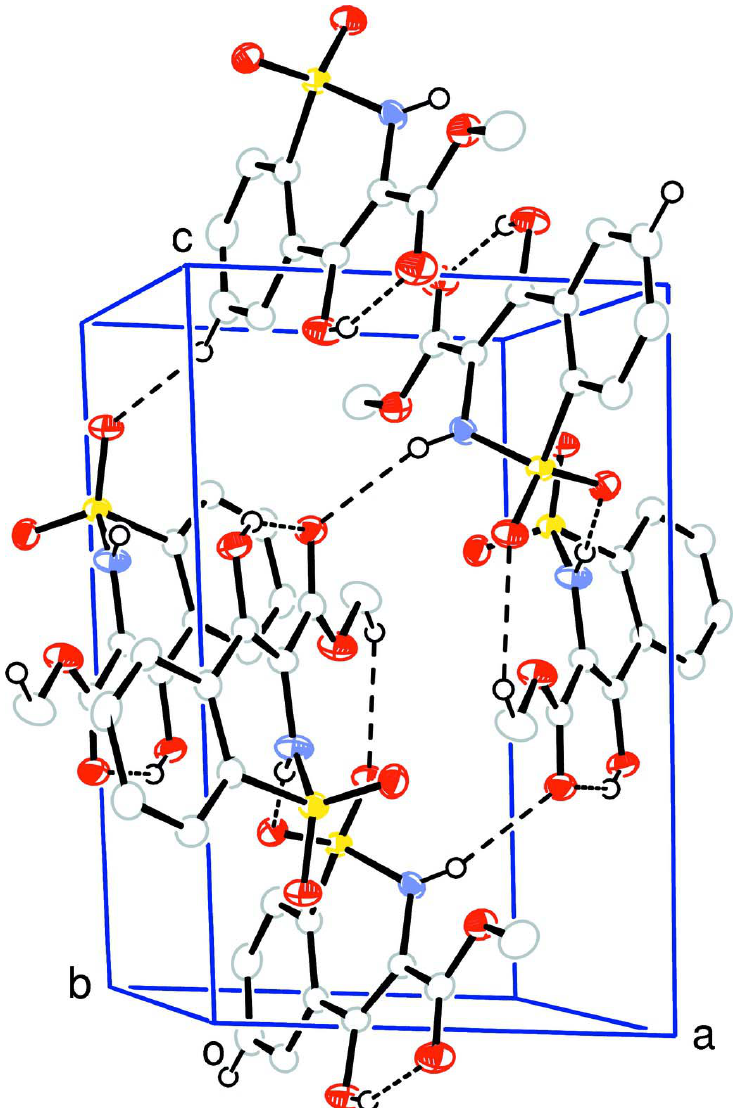
Part of the crystal structure showing H-bonding interactions (classical in red, non-classical in green and intramolecular in black) indicated by dashed lines, H-atoms not involved in H-bonds have been